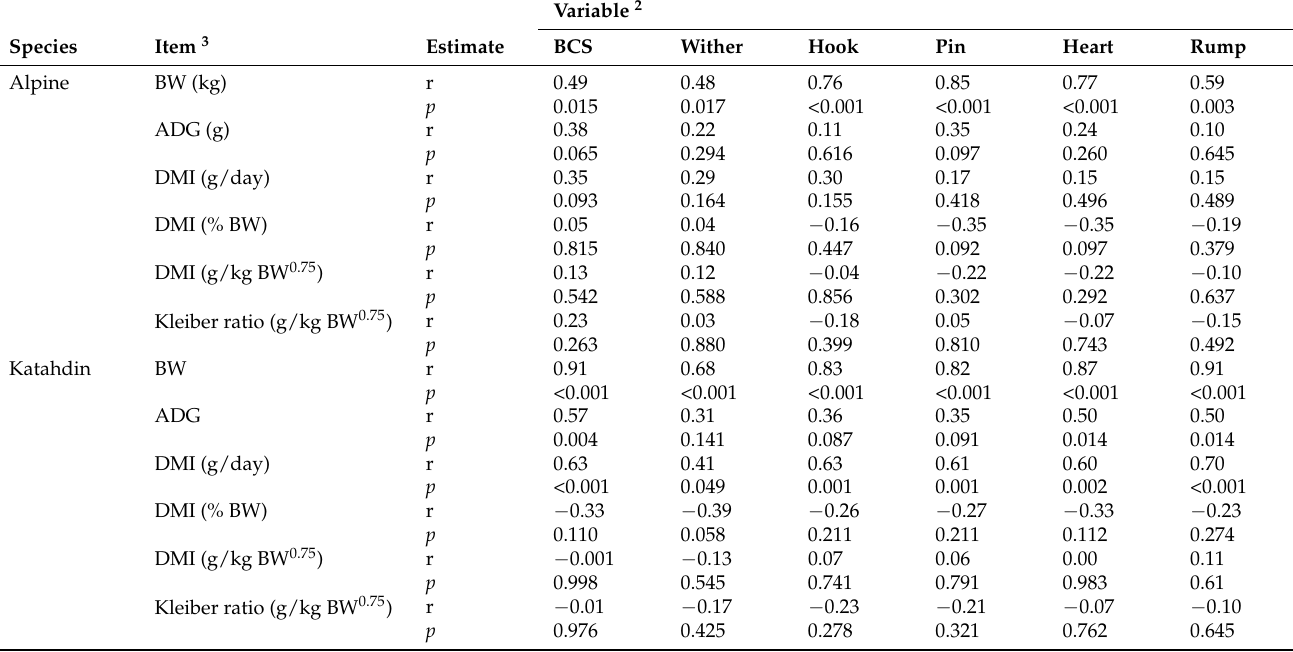
Table 4. Pearson correlation coefficients (r) between body weight, average daily gain, dry matter intake, Kleiber ratio, body condition score, and linear measures 1